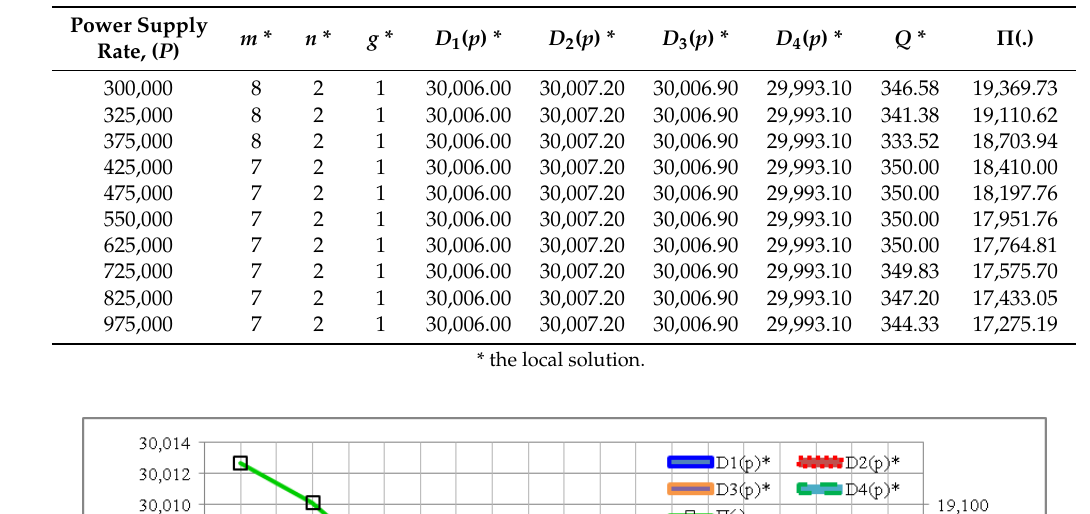
Table 10. Effect of Changes in the Power Supply Rate Parameter.